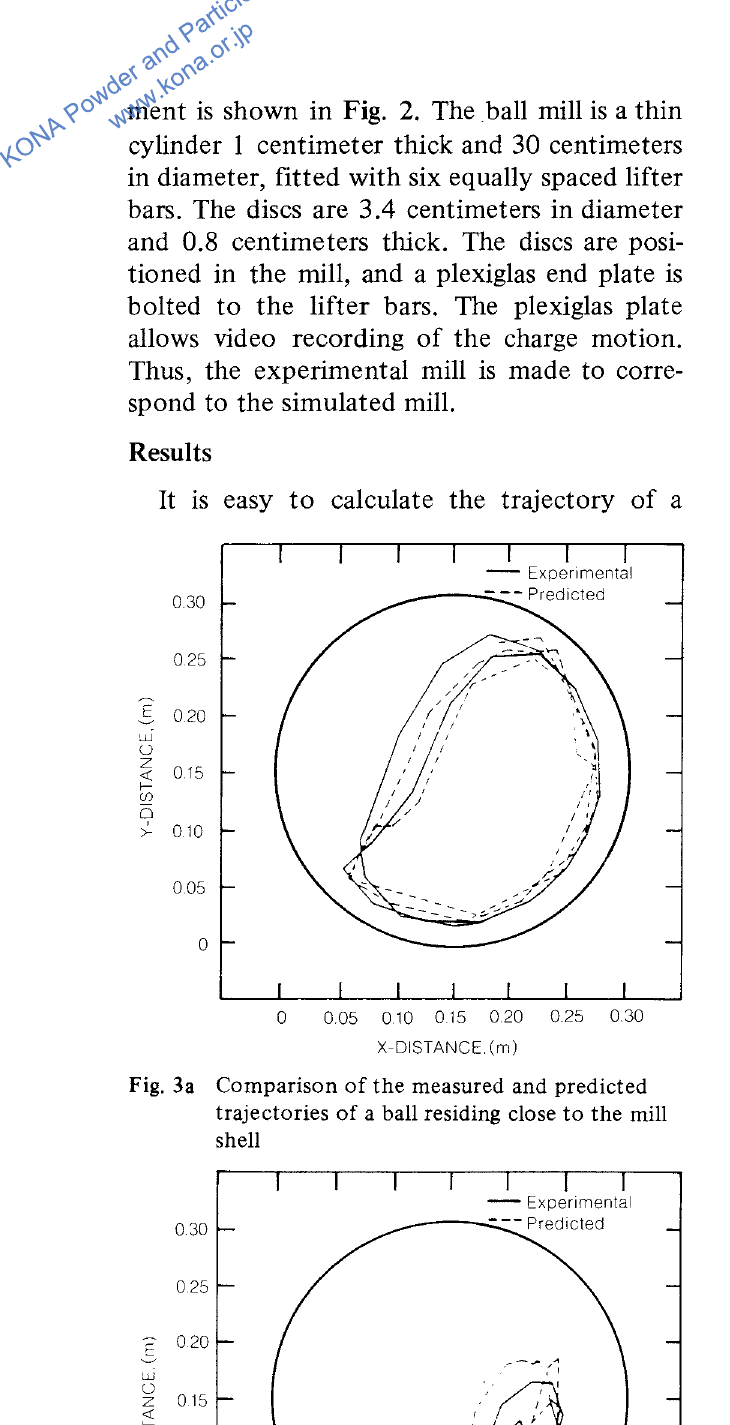
Fig. 4 Comparison of the measured and predicted toe and shoulder positions of the load at various